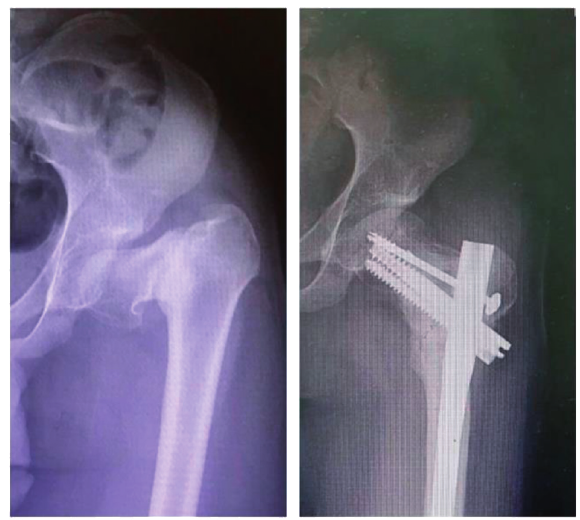
Figure 4: AP radiograph of left hip illustrating the preoperative and postoperative